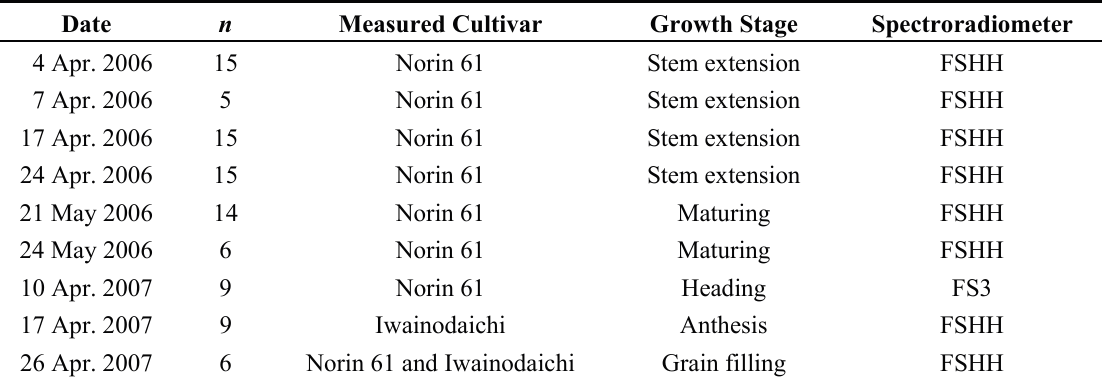
Table 2. Overview of the field spectral